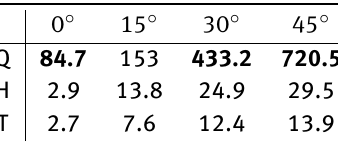
Table 1: Maximum displacement [mm] at the Serviceability Limit